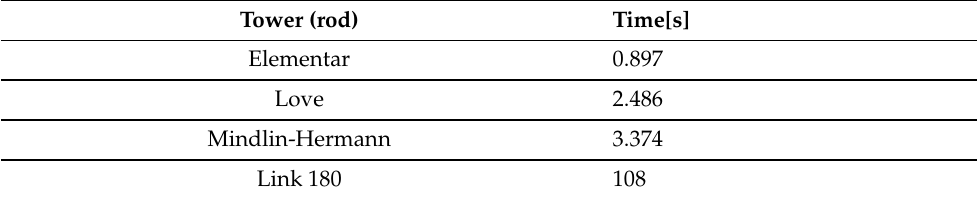
Table 4. Tower computational processing time for each